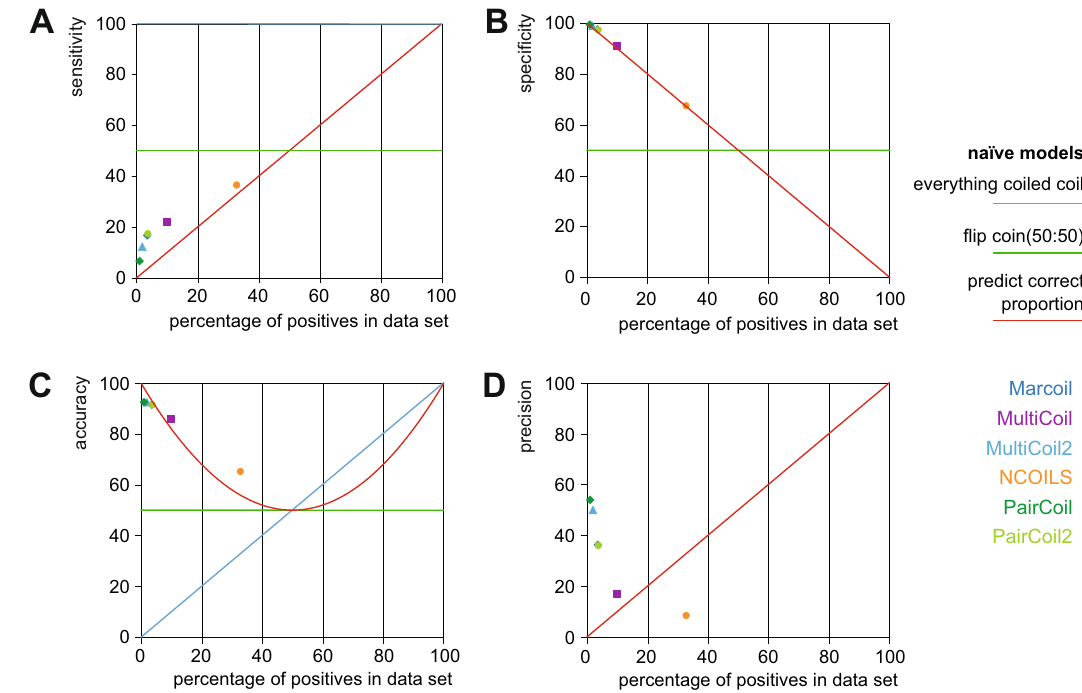
Figure 3. Performance of coiled-coil prediction tools compared to three naïve models.The plots present statistical measures based on three naïve models as described in the legend. The respective performance of the coiled-coil prediction tools based on the unreduced data is plotted for